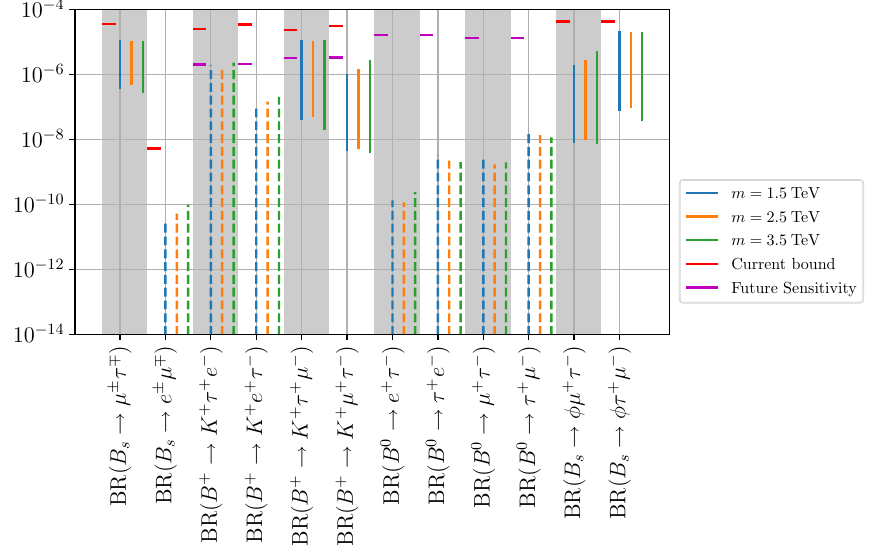
Fig. 6 Lepton flavour violating decay modes of beauty-flavoured mesons to τ -leptons, to be searched for at Belle II. The 90% ranges are obtained from sampling points around the best-fit point. Line and colour coding as in Fig.